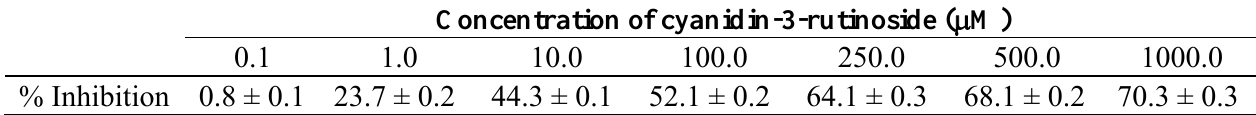
Table 1. The percentage enzyme inhibition of cyanidin-3-rutinoside (C3R) on pancreatic α -amylase. Results are expressed as mean ± S.E.M., n = 3.